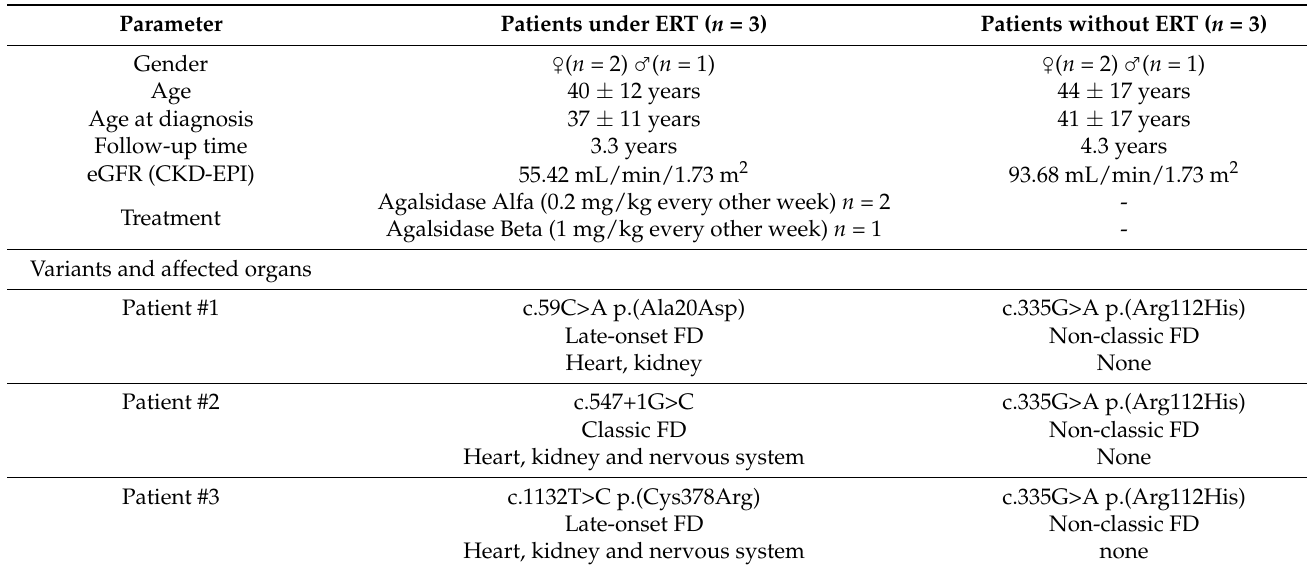
Table 1. Baseline Fabry patient (screening group)